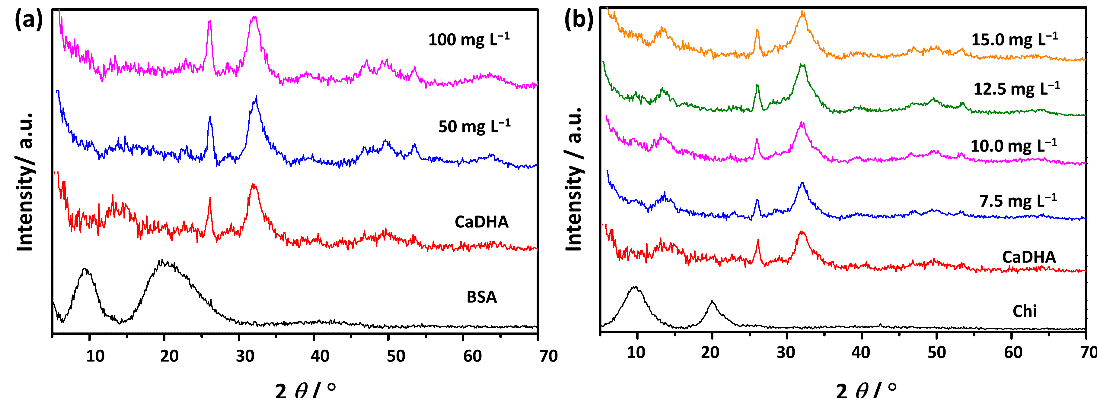
Figure 3. PXRD patterns of the precipitates obtained in the control system (CaDHA) and in the presence of different concentrations of ( a ) bovine serum albumin (BSA) after 60 min and ( b ) chitosan (Chi) after 120 min. c (CaCl 2 ) = c (Na 2 HPO 4 ) = 4 × 10 − 3 mol dm − 3 , pH init = 7.4, ϑ = (25 ± 0.1) °C.